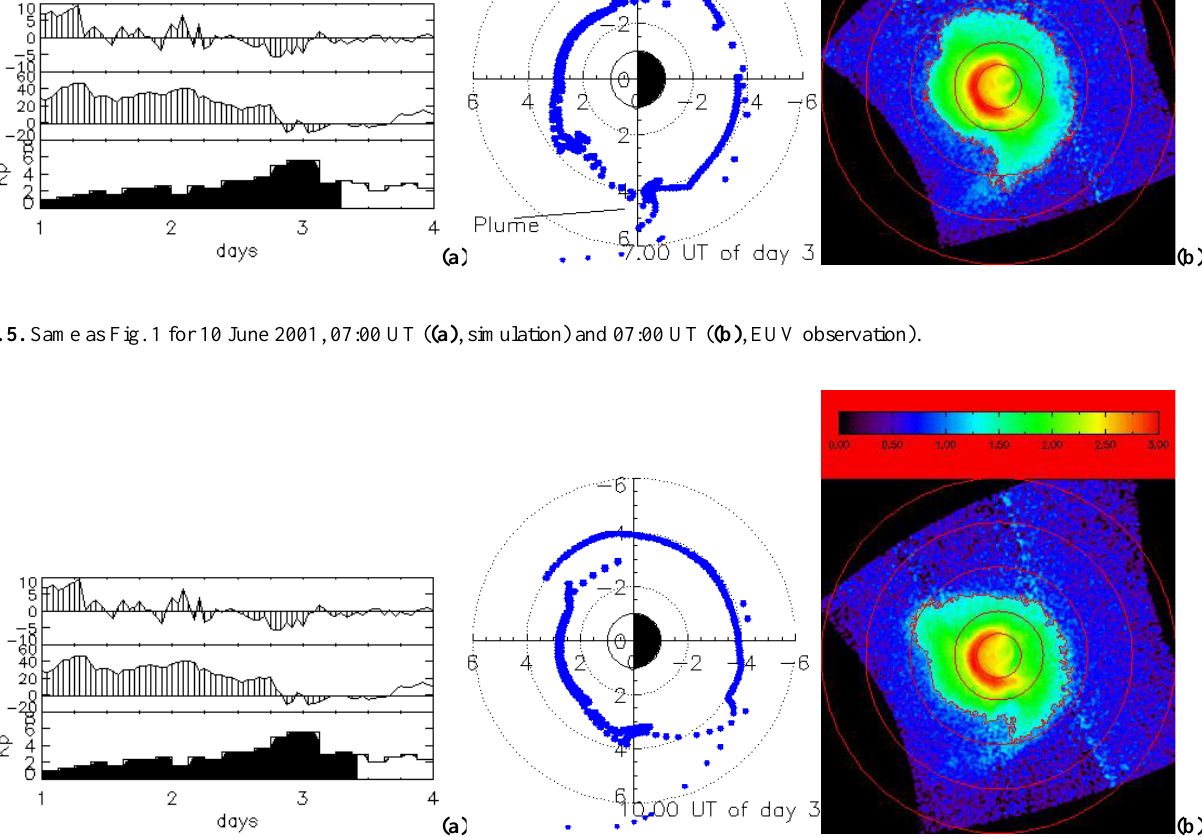
Fig. 6. Same as Fig. 1 for 10 June 2001, 10:00 ( (a) , simulation) and 09:57 UT ( (b) , EUV observation).